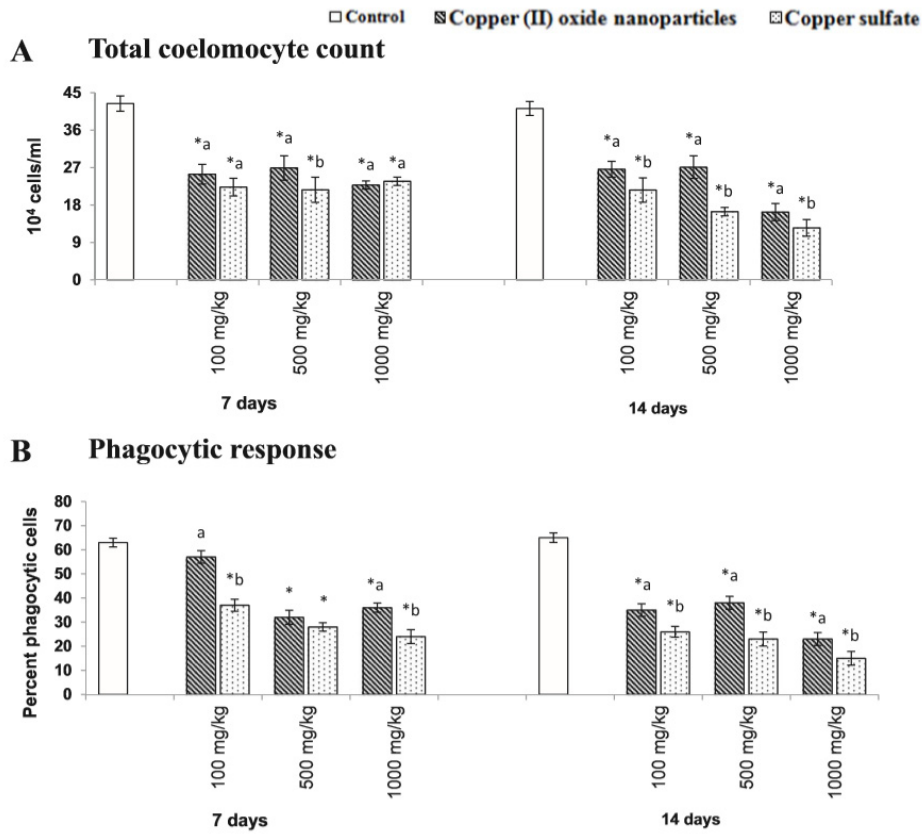
Figure 8. Total coelomocyte count ( A ) and phagocytic response ( B ) of coelomocytes of Metaphire posthuma exposed to 100.0, 500.0, and 1000.0 mg of copper nanoparticles and copper sulfate per kg soil for seven and fourteen days. Asterisk (*) signifies the data considerably different from control ( p < 0.05). Different letters (a and b) signify the substantial difference between the copper nanoparticle and copper sulfate treatment sets for each experimental concentration. Reproduced with permission from [168]. Elsevier, 2018